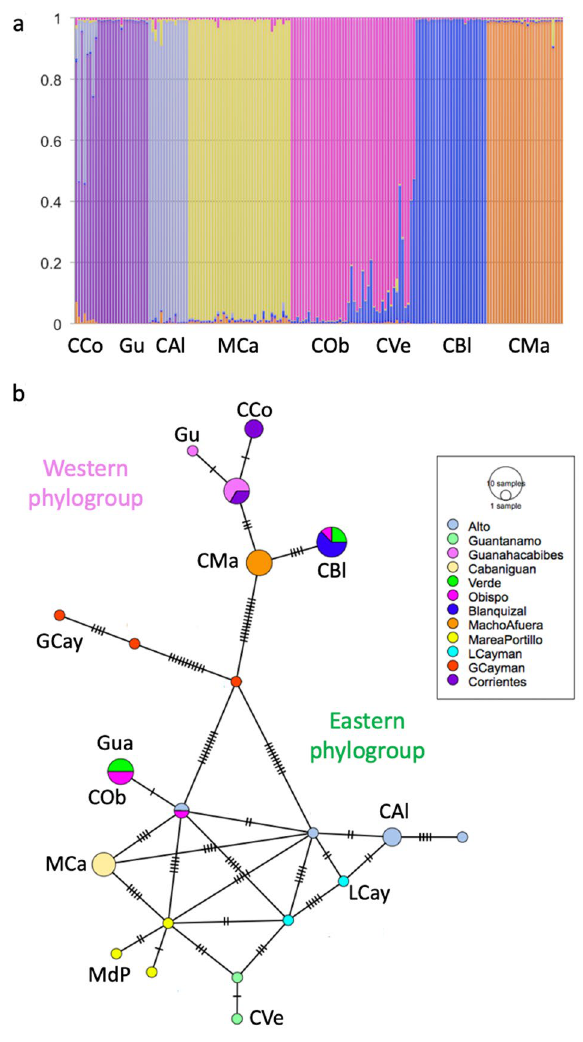
Figure 2. ( a ) Admixture proportions from Structure ( K = 6) for Cyclura nubila nubila from Cuba. Each vertical bar corresponds to an individual and different colors indicate their ancestry to the different clusters. CCo: Cabo Corrientes, Gu: Guanahacabibes, CAl: Cayo Alto, MCa: Monte Cabaniguán, COb: Cayo Obispo, CVe: Cayo Verde, CBl: Cayo Blanquizal, CMa: Cayo Macho. ( b ) Minimum spanning haplotype network for samples of C. n. nubila from Cuba, and C. n. caymanensis and C. lewisi , from Cayman and Little Cayman islands. Circles represent haplotypes and circle size is proportional to haplotype frequency. Color of circles depict the sampling locality or site of origin of samples (see insert). Abbreviations refer to Gu: Guanahacabibes, CCo: Cabo Corrientes, CBl: Cayo Blanquizal, CVe: Cayo Verde, COb: Cayo Obispo, CMa: Cayo Macho,